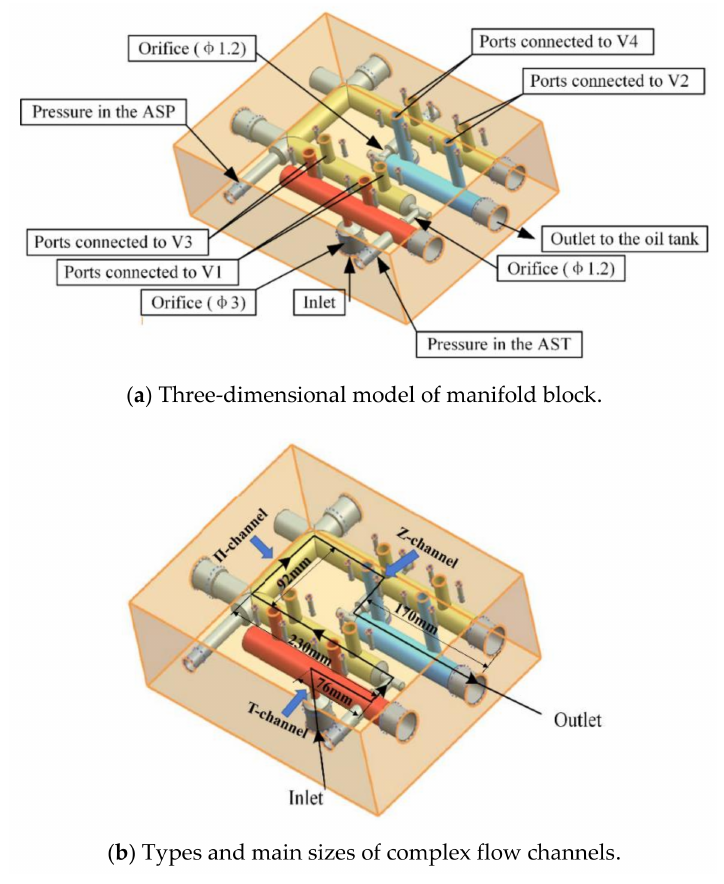
Figure 4. Structure of manifold block: ( a ) Three-dimensional model of manifold block; ( b ) Types and main sizes of complex flow